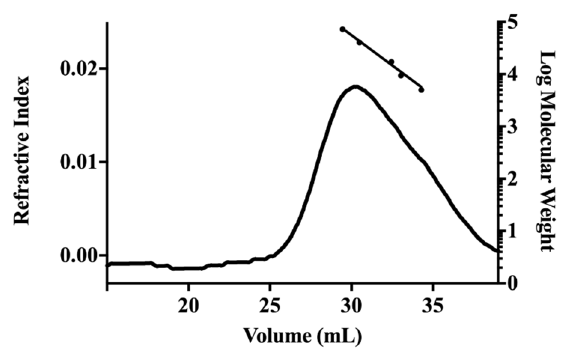
Figure 1. HPSEC elution profile of fraction P-EA. Refractive index detector. Elution volume of dextran standards of molecular weight 72.2 kDa, 40.2 kDa, 17.2 kDa, 9.4 kDa, and 5 kDa (left to right) were employed to construct the calibration